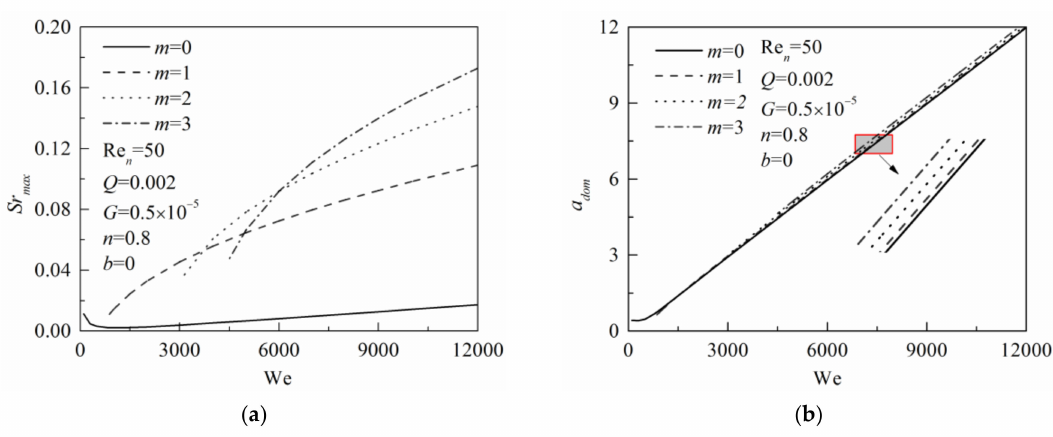
Figure 5. E ff ect of Weber number on the maximum growth rate ( a ) and the dominant wavenumber ( b